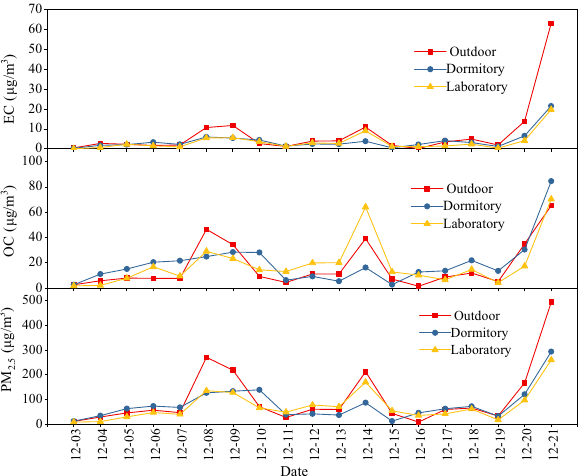
Figure 2. PM 2.5 , OC, and EC mass concentration in the outdoor, dormitory, and laboratory